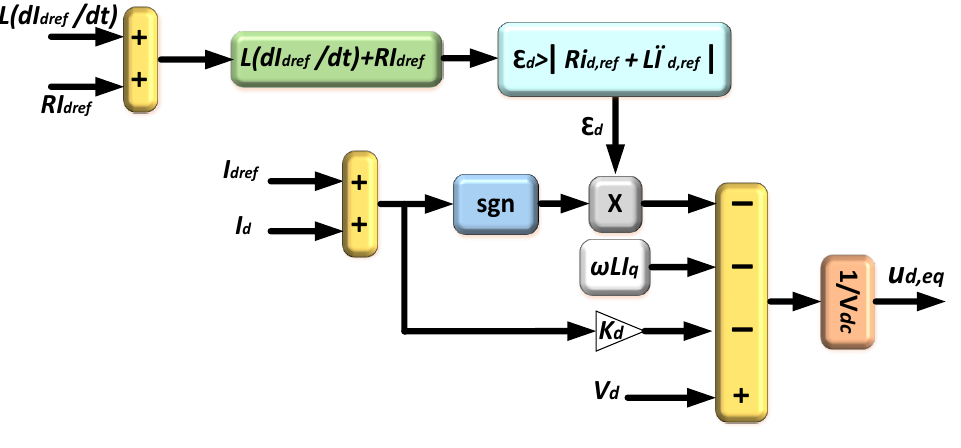
Figure 13. Sliding mode current controller (SMCC) [110].